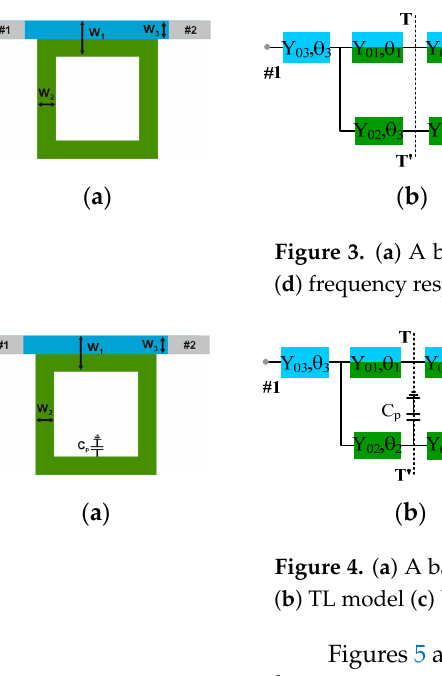
Figure 6. ( a ) A bandpass filter circuit by using a square loop resonator with perturbation element and short-circuited stubs ( b ) TL model ( c ) LE model ( d ) frequency response. ( a ) ( b ) Figure 7. ( a ) Even- ( b ) odd-mode half circuit TL models of the unit filter cell. Even- and odd-mode input admittances ( Y even/odd ) can be calculated by, 1/ 1